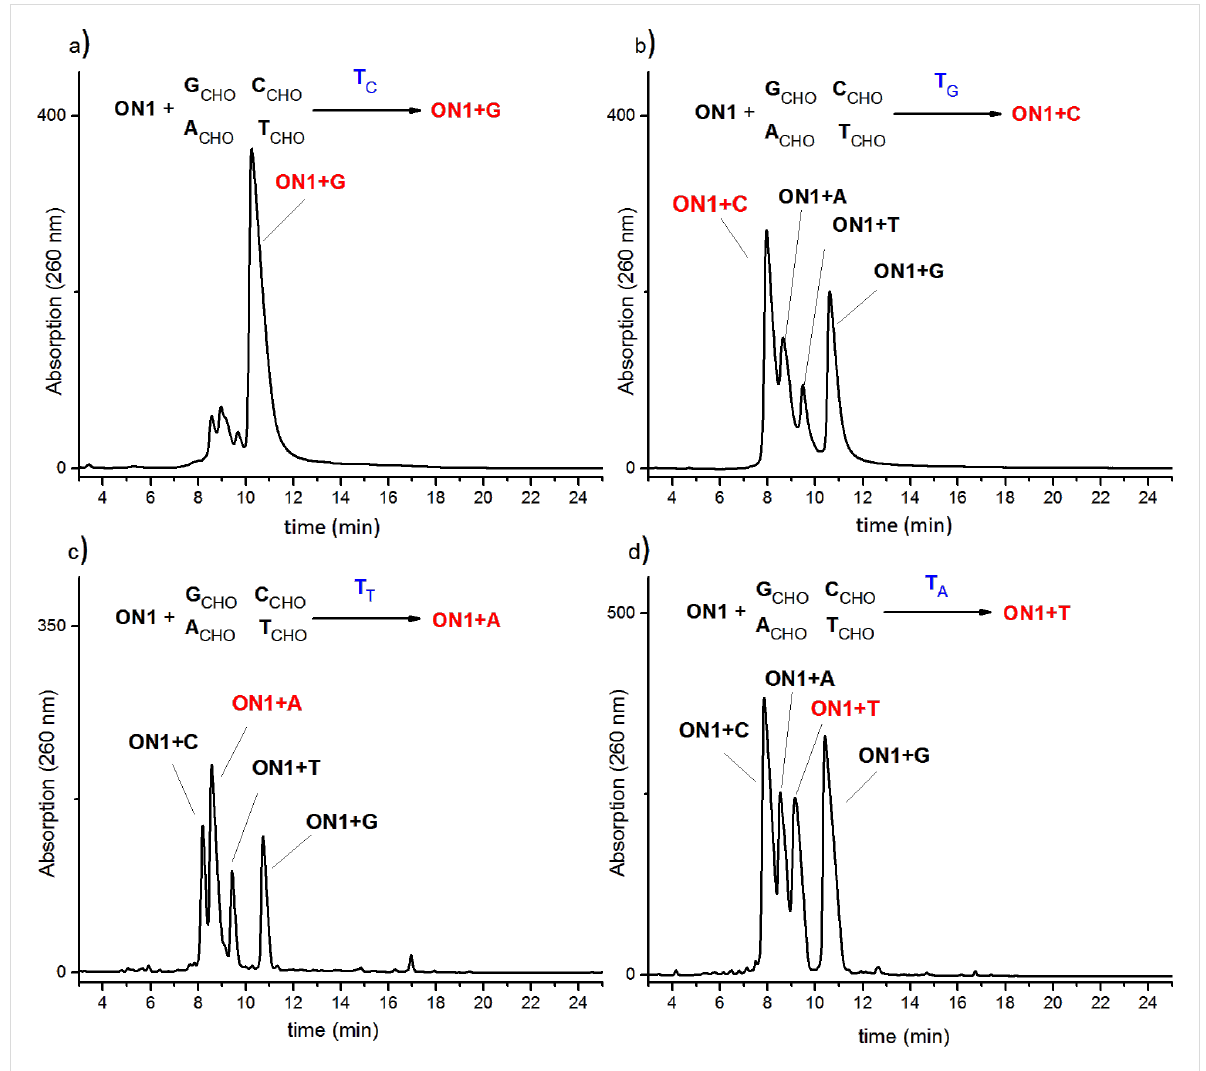
Figure 5: Representative HPLC chromatograms obtained using elevated pH, for samples collected from first purification step (in Figure 4 marked with dashed line). The samples were collected from the reaction of ON1 and four nucleobases in the presence of a DNA-template: a) T C ; b) T G ; c) T T ; d) T A . The chromatograms were obtained after reductive amination of the samples (for more details see Supporting Information File